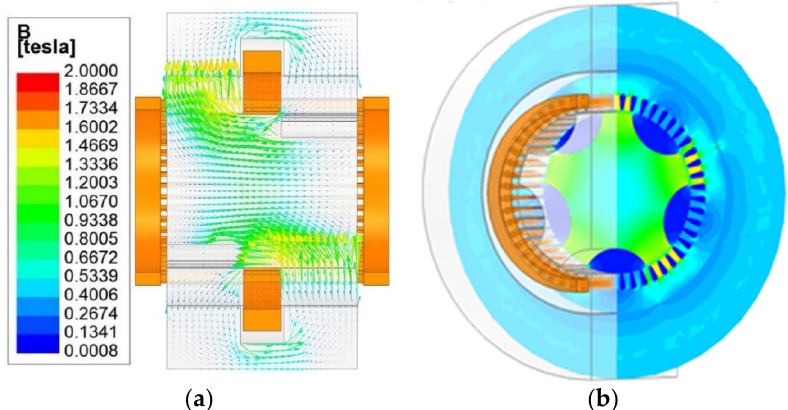
Figure 13. No-load magnetic field distribution of the axial and radial views. ( a ) The no-load magnetic field distribution of the axial view. ( b ) The no-load magnetic field distribution of the radial view.